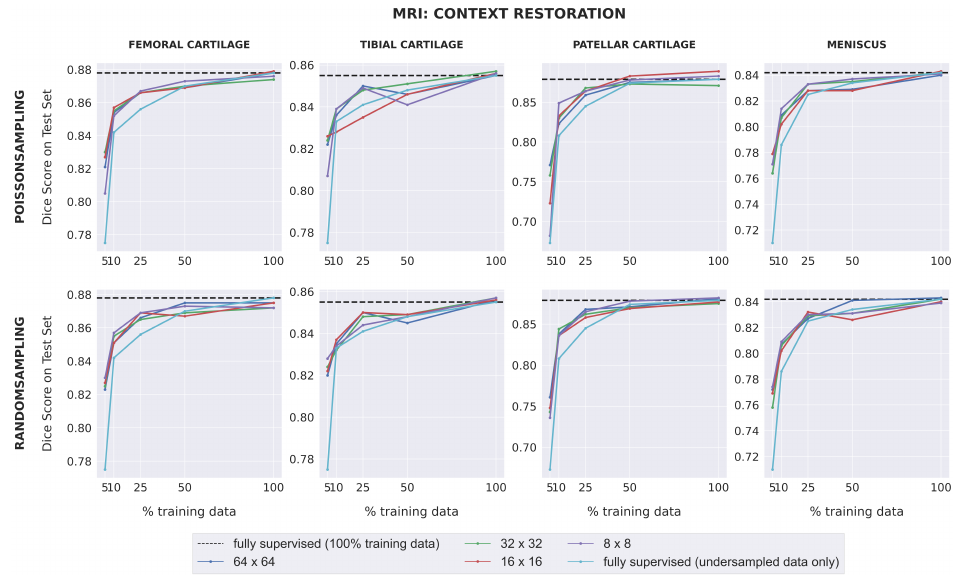
Figure 3. The downstream segmentation performance on the MRI dataset for the Context Restoration pretext task as measured by the Dice score for every combination of patch size and sampling method used during pretraining, evaluated in five different scenarios of training data availability. In each scenario, every model is trained for segmentation using one of the five different subsets of training data as described in Section 2.1.1. The black dotted line in each plot indicates the performance of a fully-supervised model trained using all available training images. The light blue curve indicates the performance of a fully-supervised model when trained using each of the five different subsets of training data. Similar plots for the Context Prediction pretext task are given in Appendix